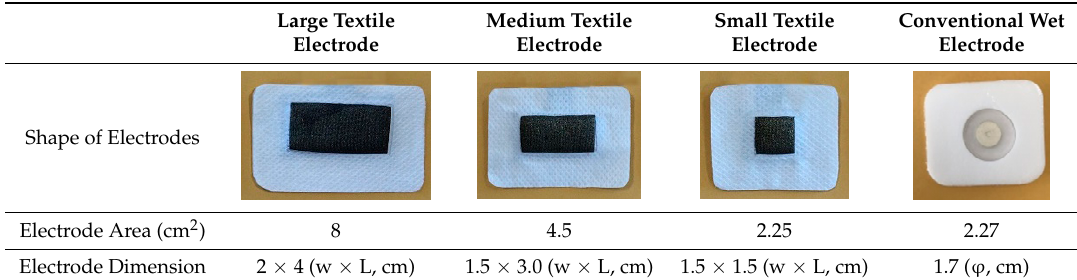
Table 2. Electrodes in different